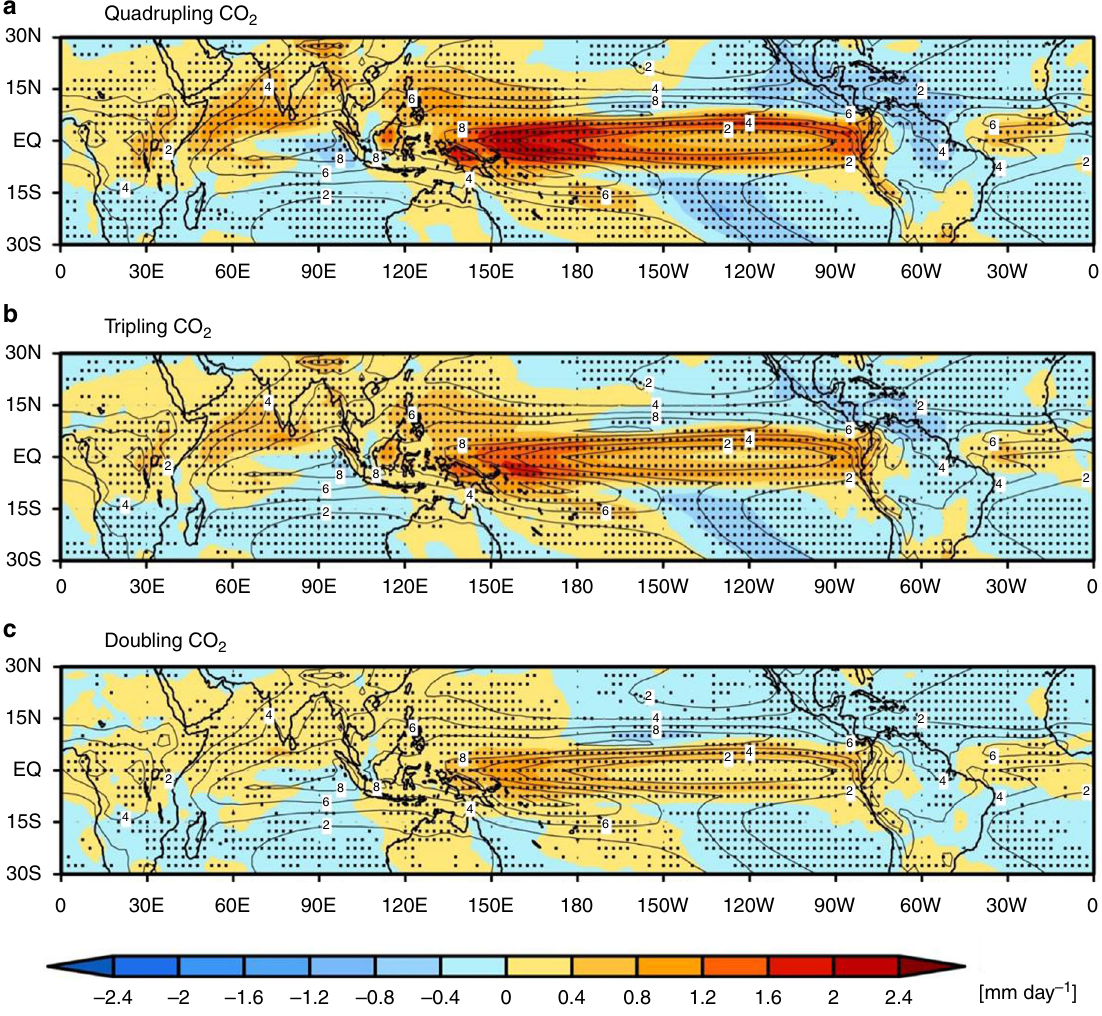
Fig. 2 Changes in the spatial pattern of precipitation in response to CO 2 concentration increases. Difference distribution of ensemble mean annual precipitation for the a quadrupling, b tripling, and c doubling of CO 2 concentration. Contours represent ensemble mean fi eld of precipitation for the fi rst 20 years with intervals of 2 mm day − 1 in each experiment. Dotted denotes the region where the responses of 14 or more out of the 21 CMIP5 models are